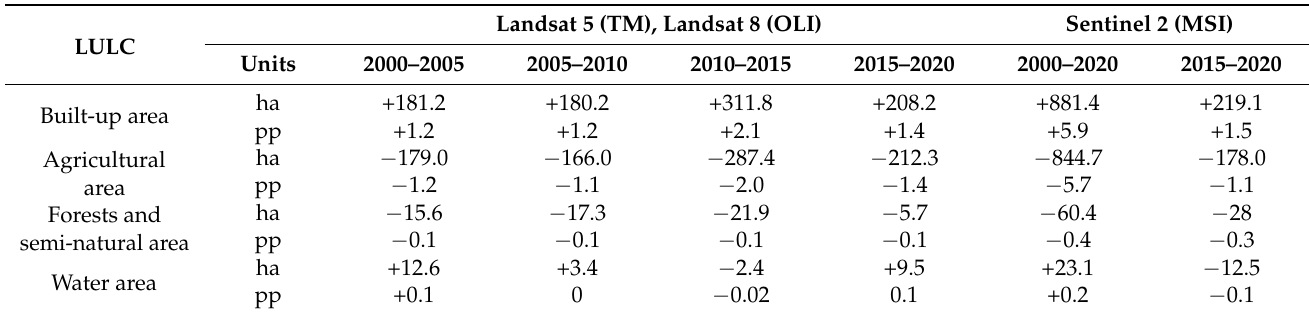
Table 3. Changes LULC in Opole obtained on the basis of processing of satellite imagery: Landsat (2000, 2005, 2010, 2015, 2020) and Sentinel (2015, 2020) (difference in area and percentage points).